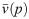
Conduction velocity along progressively remyelinated axons for the Gow and Devaux TJ model.The black circles represent the average CV (and standard deviation) for 500 model neurons with a given fraction of remyelinated segments with a g-ratio of 0.69; the blue solid curve is the benchmark velocity v¯(p) for this case. The purple diamonds represent the average CV (and standard deviation) for 500 model neurons with a given fraction of remyelinated segments whose g-ratio is 0.86; the red solid curve is the benchmark velocity v¯(p) for this case.